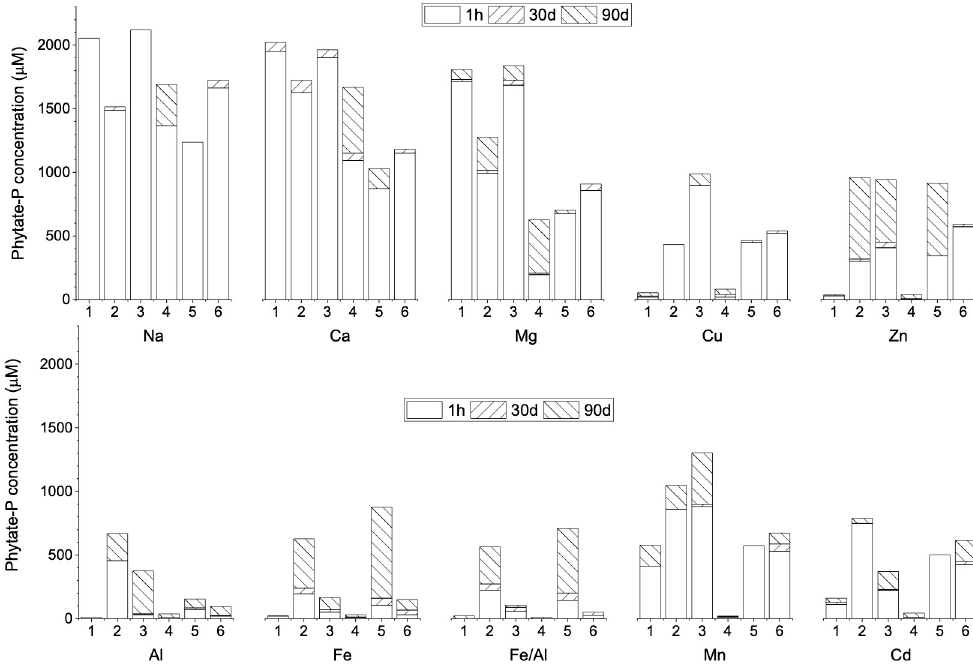
Fig 1. Dissolved concentration of metal phytate P in two different buffer systems at three different times (1h, 30d, and 90d). The initial concentration of metal phytate complex in the solution was 300 mg/L (about 0.227–0.397 mM of phytate or equivalent of 1.38–2.38 mM phytate-P) in each experiment. The concentration of metal phytate was quantified as the difference between total soluble P and inorganic P (P i ). The numerals in X-axis represent: 1) 20 mM NaAc (pH 5.0), 2) 20 mM NaAc + 3 mM EDTA, 3) 20 mM NaAc + 3 mM citric acid, 4) 20 mM Tris-HCl (pH 7.5), 5) 20 mM Tris-HCl + 3 mM EDTA, and 6) 20 mM Tris-HCl + 3 mM citric